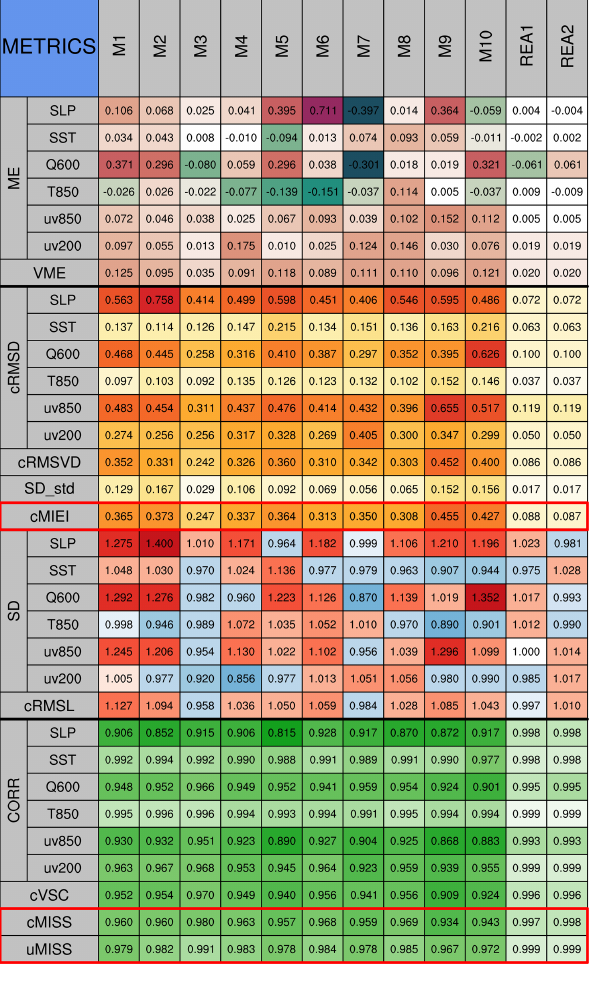
Figure 5. Metrics table of centered statistics. The table evaluates the performance of 10 CMIP5 models in simulating climatologi- cal mean (1961–2000) 600hPa specific humidity (Q600), sea level pressure (SLP), sea surface temperature (SST), 850hPa temperature (T850), 850hPa winds (uv850) and 200hPa winds (uv200) in the Northern Hemisphere in autumn (September–October–November). ME (VME) is the error of the mean scalar or vector (multivariable) fields. cRMSD (cRMSVD) is the overall difference in scalar or vec- tor (multivariable) anomaly fields between model and observation. CORR (cVSC) and SD (cRMSL) are the pattern similarity and am- plitude of the anomaly fields for the individual variable (multivari- able field). SD_std is the standard deviation of SD values. cMISS (uMISS) is the multivariable integrated skill score of the anomaly (original) fields, which is calculated with SD (rms) values and cVSC (VSC). cMIEI is the centered multivariable integrated index. The factor F in cMISS and uMISS is 2. The colors represent the val- ues of statistical metrics. The lighter colors indicate better model